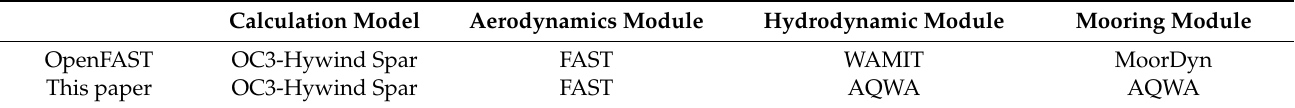
Table 5. Comparison of two calculation models.